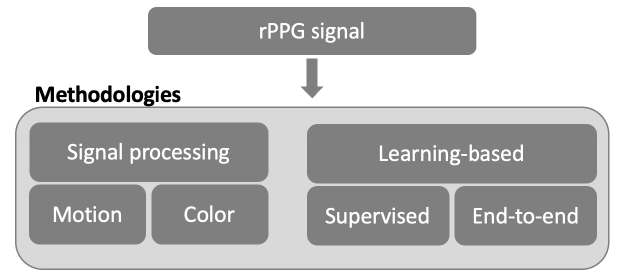
Figure 1. Classification of processing approaches for HR estimation through rPPG signals, using a stream of images as